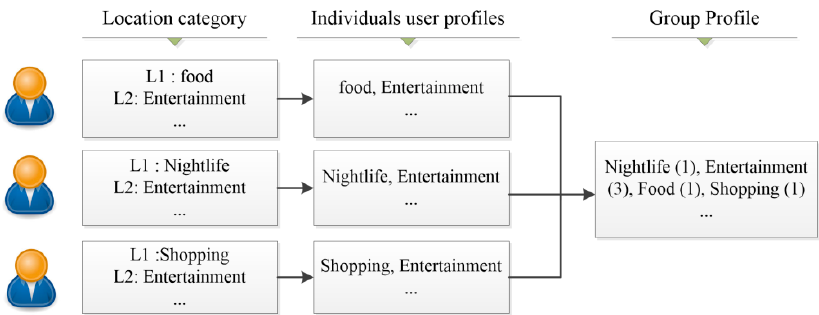
Figure 3. Group profile creation for the members of the group based on the category of visited locations .